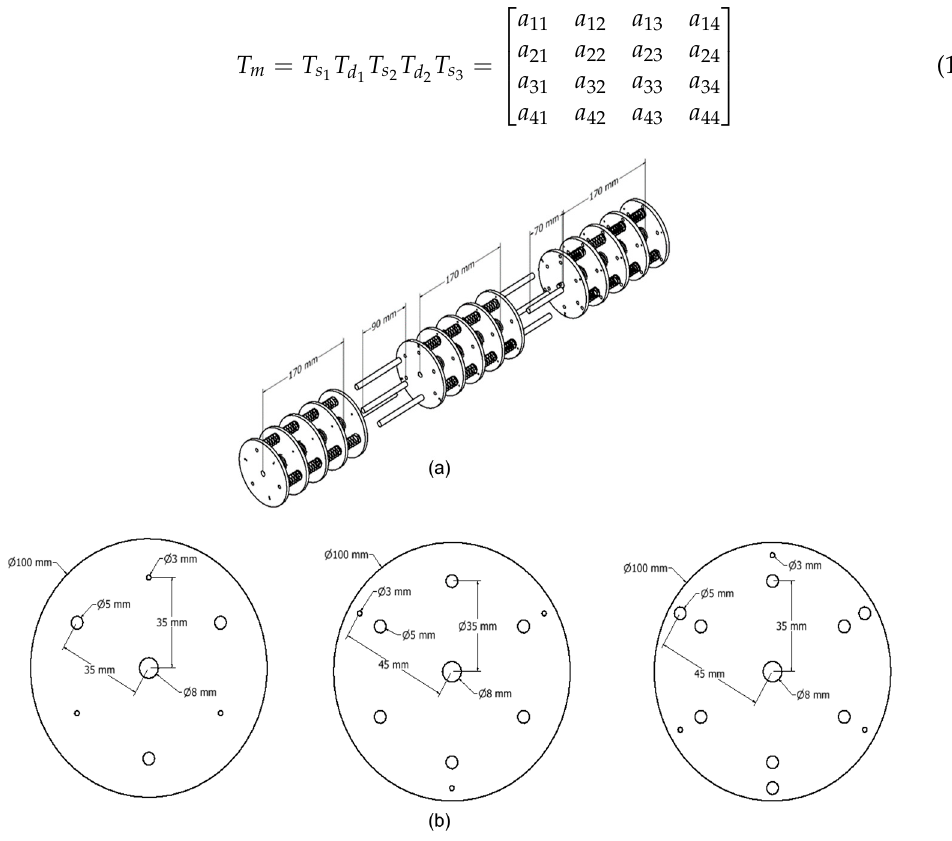
Figure 7. Relation between the tension cables and arc parameters: ( a ) three-dimensional and ( b ) two- dimensional.